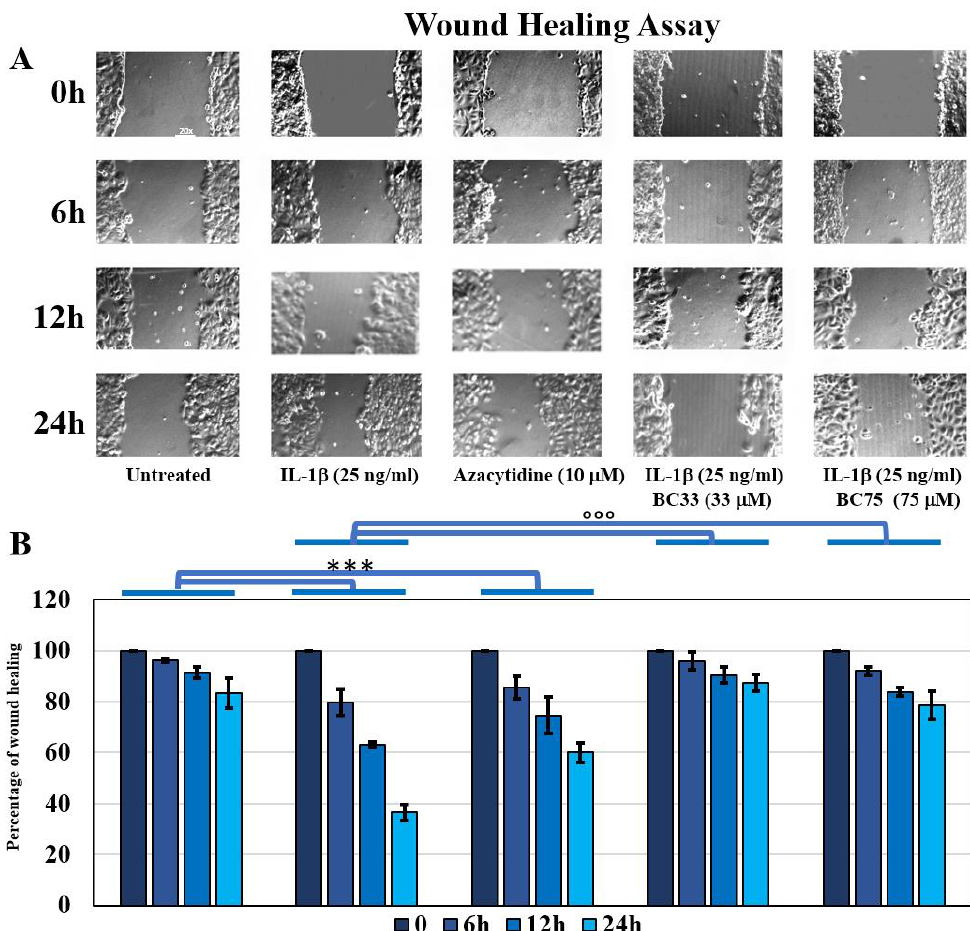
Figure 2. ( A ) Representative images of wound healing assay of MCF-7 cell line following the different treatments (20× magnification). ( B ) Percentage of wound healing for each tested treatments at each experimental time (Mean ± SD, n = 3). Two-way ANOVA showed a significant interaction of treatment and experimental time factors on wound healing data (F = 38.70, p < 0.0005). Significant differences among tested treatments versus untreated MCF-7 (*), and versus IL-1 β MCF-7 (°) are reported in the graphs (*** and °°°, p, < 0.0005).